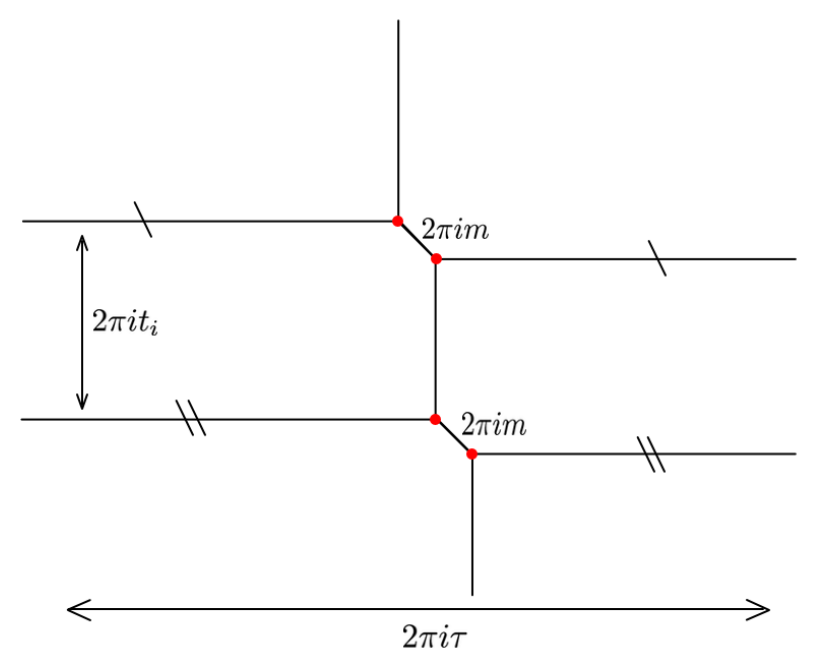
Figure 5 . The periodic toric geometry for the A 1 case. For A n (cid:0) 1 case we get n horizontal lines. The t i are the Coulomb branch parameters and m corresponds to the mass of the adjoint in the N = 2 (cid:3)